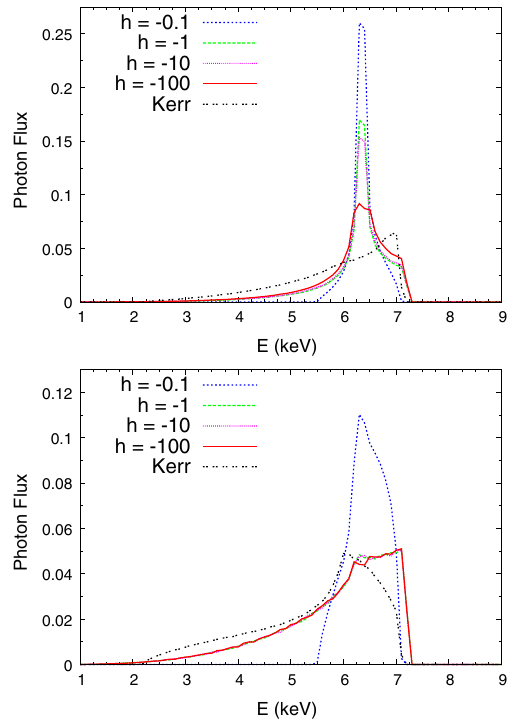
Fig. 3 Shape of the iron K α line expected in the reflection spectrum of an accretion disk in the Bonnor space-time for different values of the constant h . These lines have been computed assuming the viewing angle i = 45 ◦ , the inner edge of the disk r in = 1, and the intensity profile I e ∝ 1 / r q , where the emissivity index is q = 3 ( top panel ) and 5 ( bottom panel ). For comparison the corresponding line in the Kerr space-time with a = 0 . 7 is plotted as well (see text for more